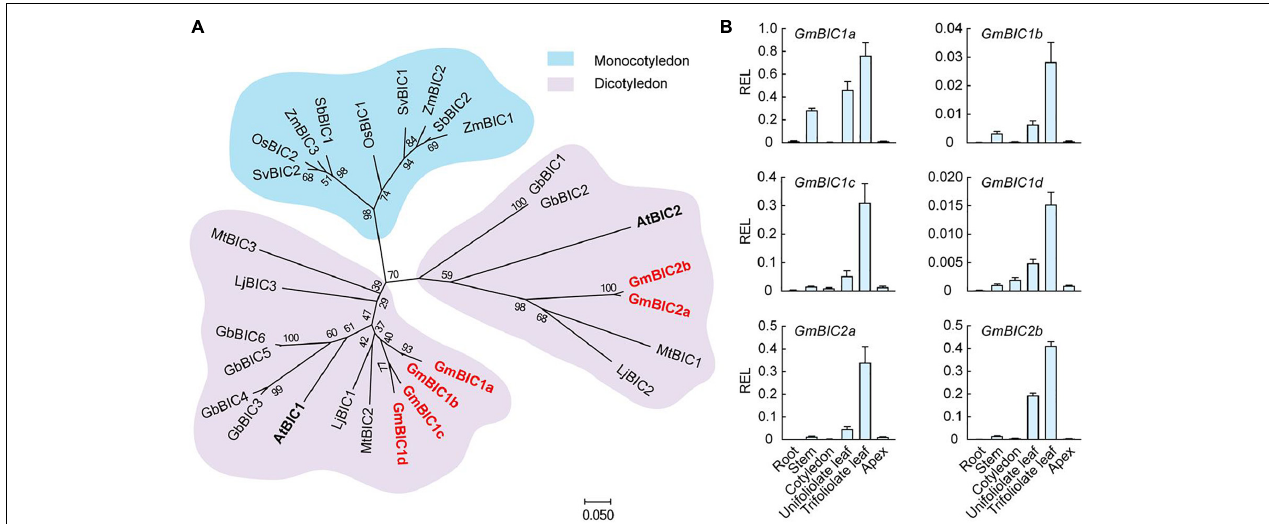
FIGURE 1 | Phylogeny and tissue-specific transcriptional analysis of GmBICs . (A) Phylogenetic tree of GmBIC proteins with other plant BIC proteins using the neighbor-joining method by the MEGA7. The bootstrap analysis employed 1,000 replicates. Nomenclatures are as follows: At, Arabidopsis thaliana ; Gm, Glycine max ; Lj, Lotus japonicus ; Mt, Medicago truncatula ; Gb, Gossypium barbadense ; Zm, Zea mays ; Os, Oryza sativa ; Sv, Setaria viridis ; and Sb, Sorghum bicolor . (B) Relative expression levels of GmBICs in different tissues of Williams 82 by qRT–PCR. Data are means ± SD ( n = 3). GmActin was used as an internal control. REL, relative expression level.